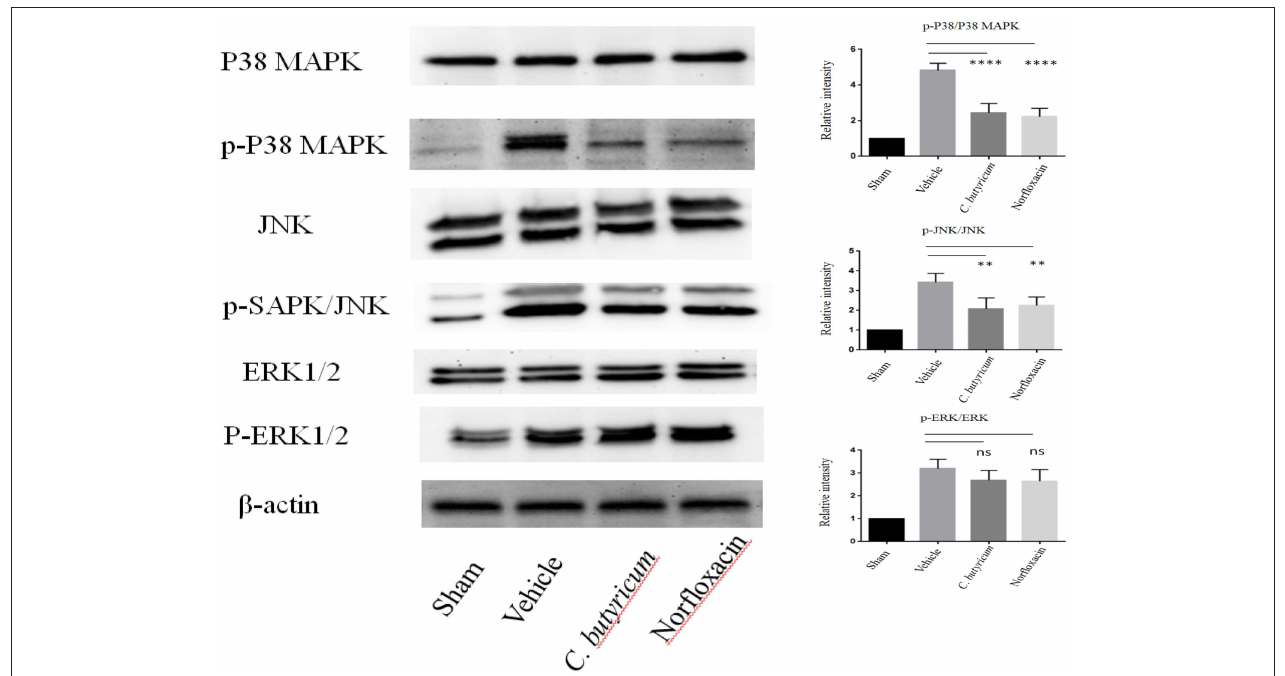
FIGURE 6 | Gut microbiota intervention suppressed the phosphorylation of p38 MAPK and JNK, but not ERK1/2 in the lumbar spinal cord of EAE mice. The expressions of p38 MAPK, JNK, ERK1/2 and their phosphorylation expression were analyzed by Western blot. Statistically significant data are indicated by asterisks (** P < 0.01 and **** P < 0.0001). ns, not